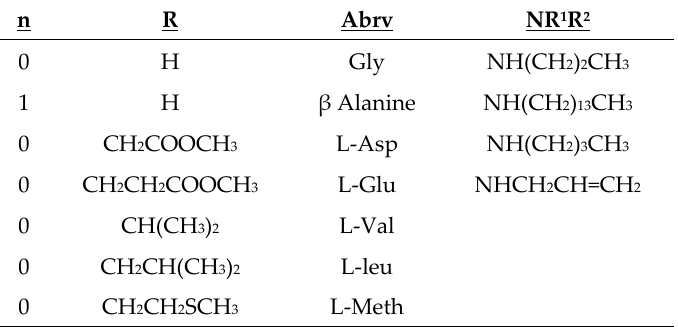
Synthetic pathways to prepare methyl-2-[3-(3-phenylquinoxalin-2-ylsulfanyl)propanamidoalkanoates ( 50 ) and N -alkyl-3-((phenylquinoxalin-2-yl sulfanyl)propanamides ( 51 ) with reagents and conditions: ( a ) NH 2 NH 2 /C 2 H 5 OH/78 °C/reflux/4 h, ( b )